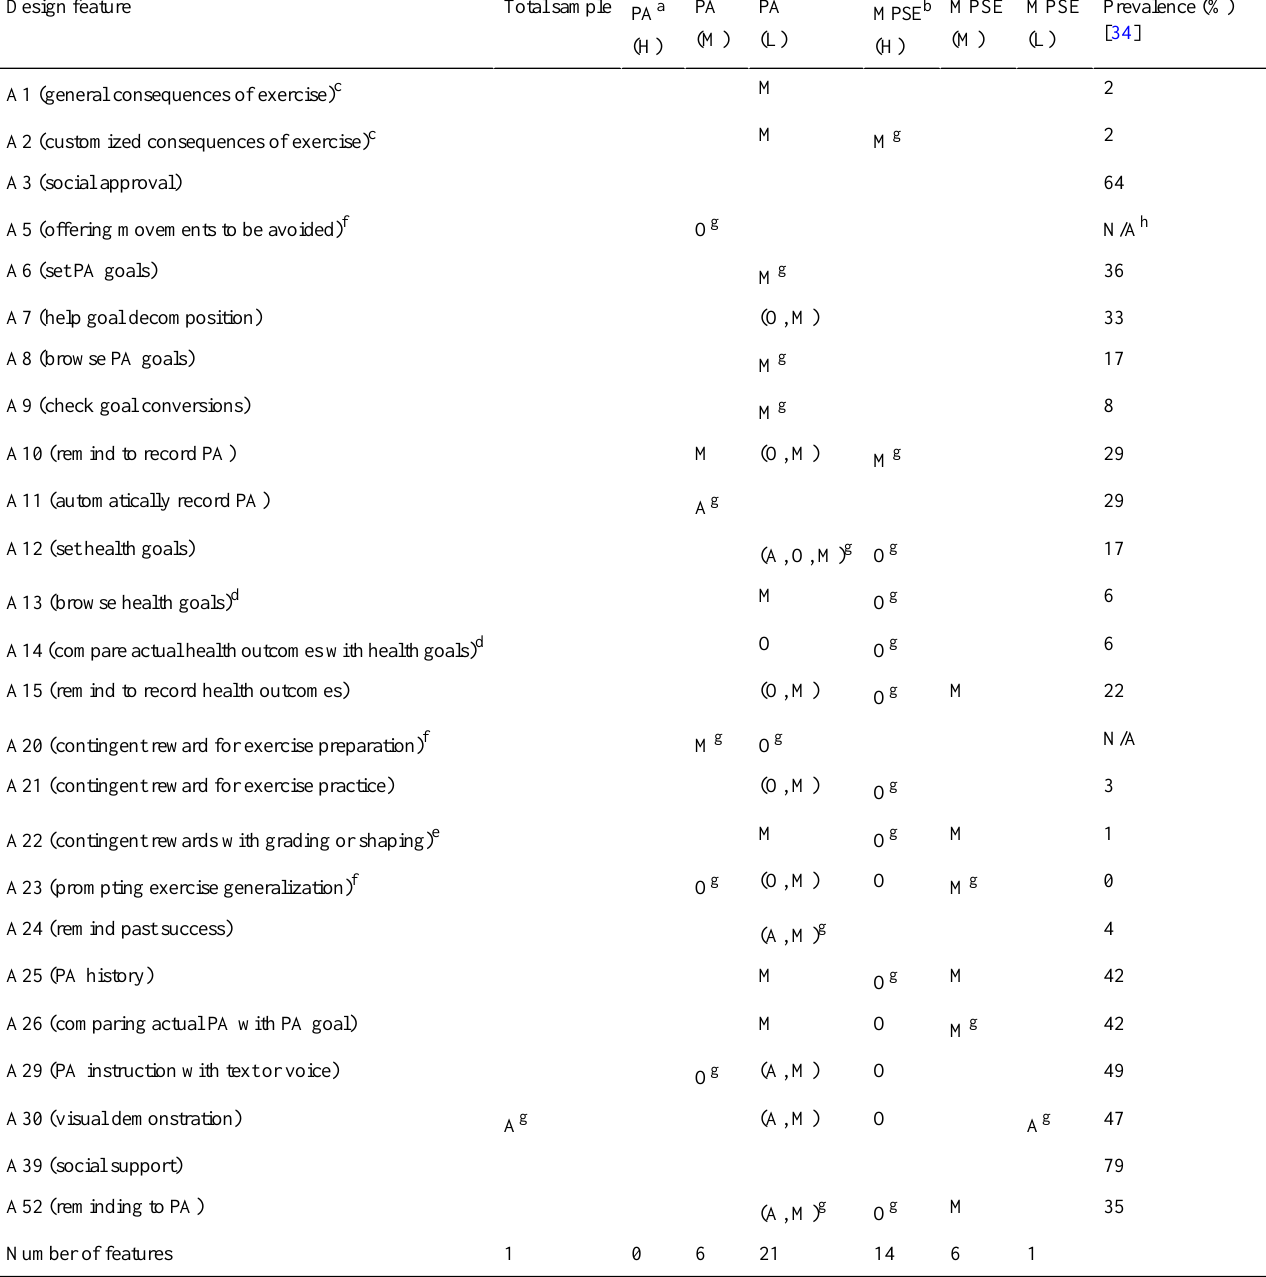
Table 11. Positive quality categories by design features and participant